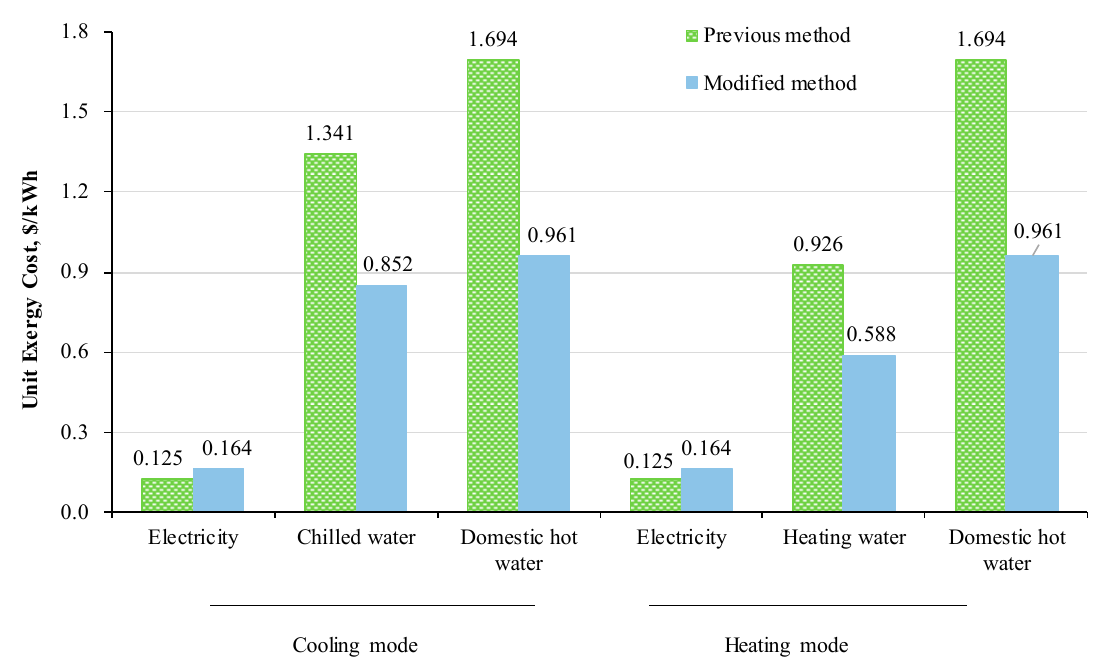
Figure 5. Unit exergy cost of products in the two operation modes.